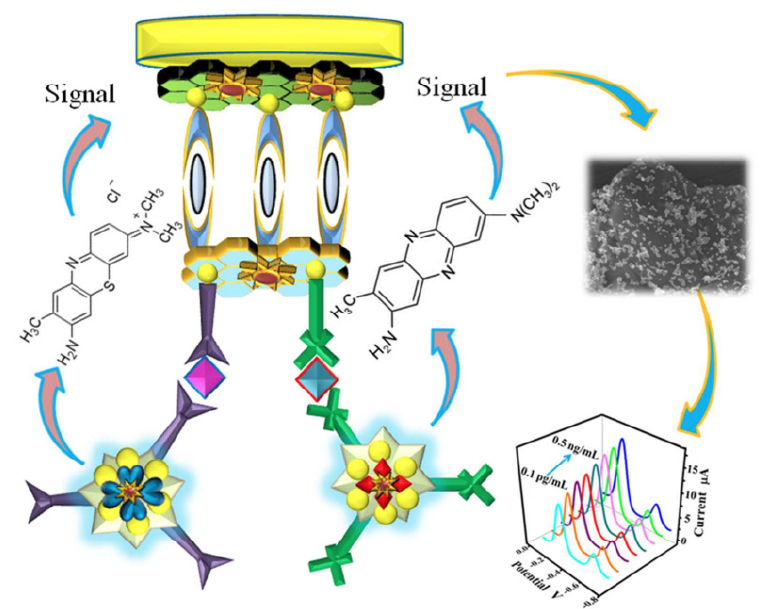
Figure 9. Representation of the tri-antibody dual-channel immunological biosensor for th edetection of cancer biomarkers. Reprinted with permission from [65]. Copyright©2017 American Chemical Society.